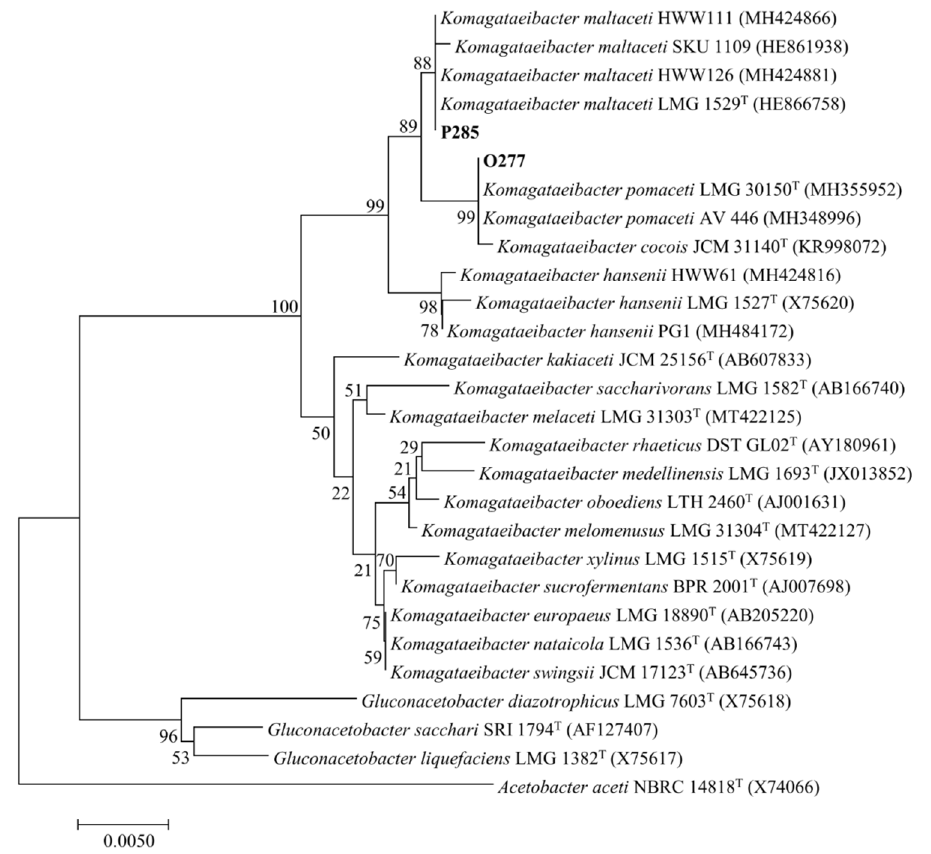
Figure 1. Phylogenetic relationships of the strains P285 and O277 (bold), some species of the genus Komagataeibacter and Gluconacetobacter , and related taxa based on 16S rRNA gene sequence analysis. The branching pattern was generated by the neighbour-joining method. Bootstrap values (expressed as percentages of 1000 replications). Bar, 0.005 substitutions per nucleotide position. Acetobacter aceti NBRC 14818 T (GenBank accession number X74066) is demonstrated as outgroup sequence.